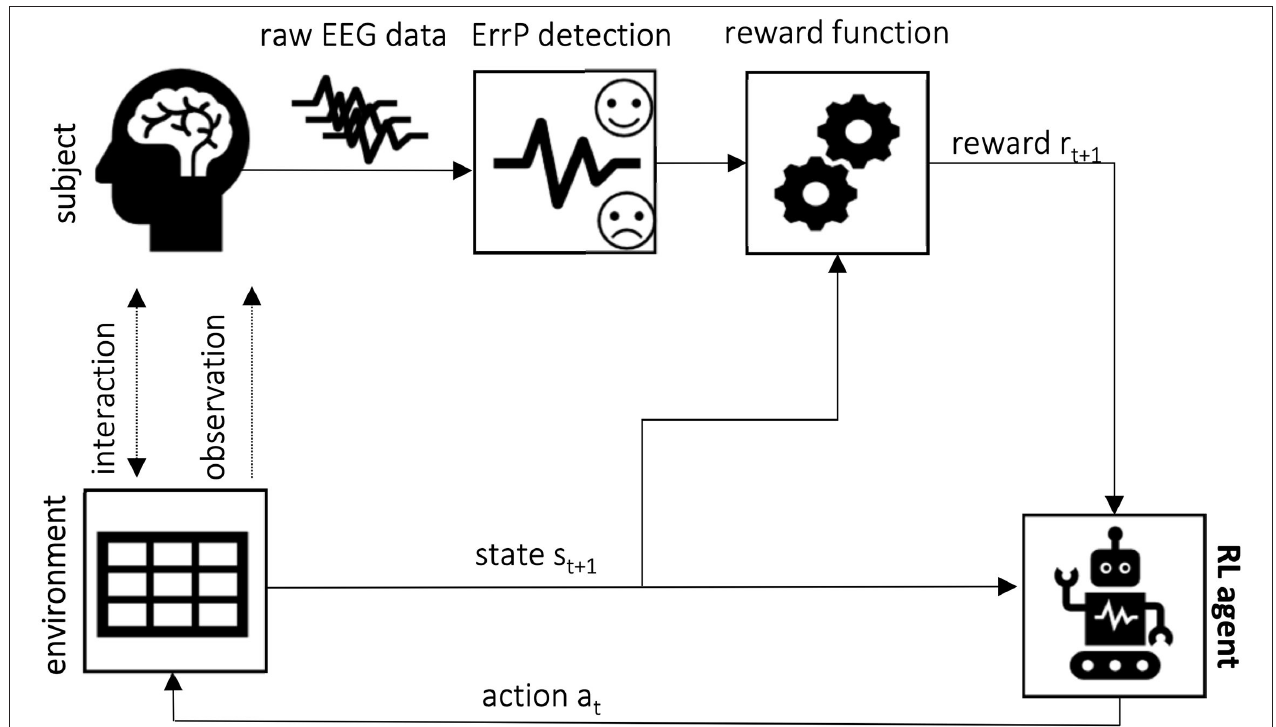
FIGURE 5 | Error-based reinforcement learning framework concept: the ErrP is used as a reward to guide the RL agent as it learns the optimal policy to achieve the desired task. The error-based reward functions penalize wrong actions and reinforce those evaluated as the correct expected behavior by the subject.